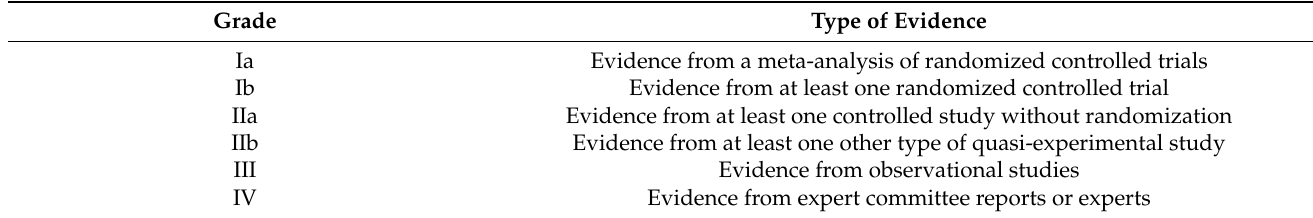
Table 2. Grading of evidence and recommendations according to the grade system.